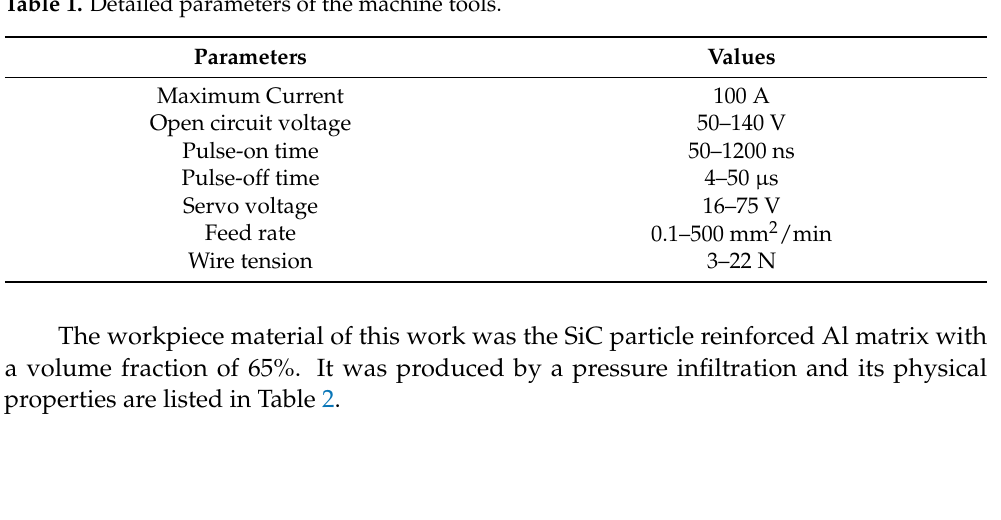
Figure 1. Practical map of the machine tools. Table 1. Detailed parameters of the machine